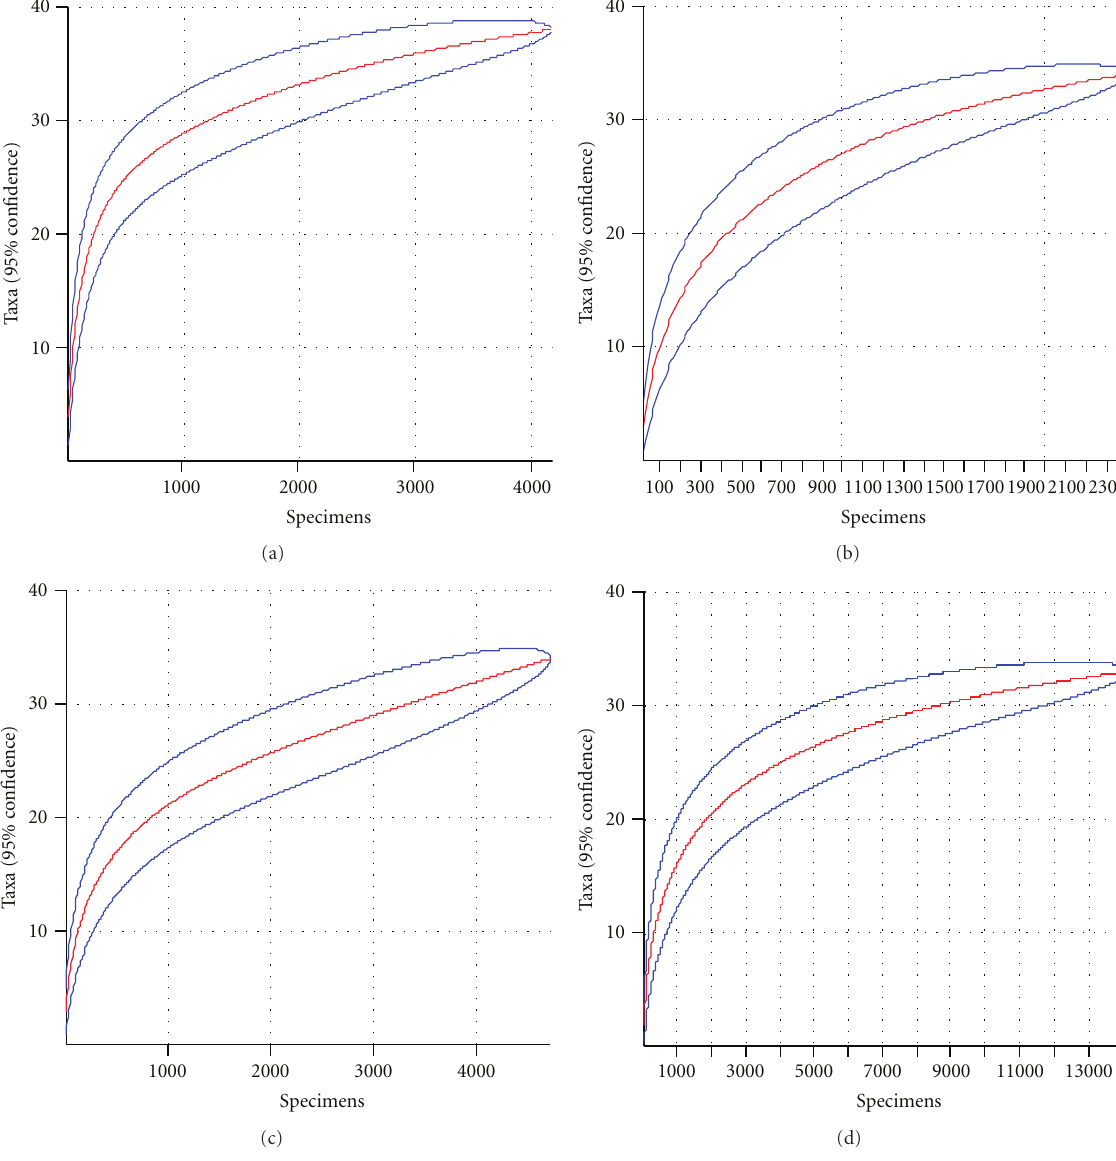
Figure 1: Rarefaction curves (accumulation of species) for di ff erent forest strata or spatial levels: (a) ground level, (b) 8 meters, (c) 16 meters, and (d) 30 meters (canopy